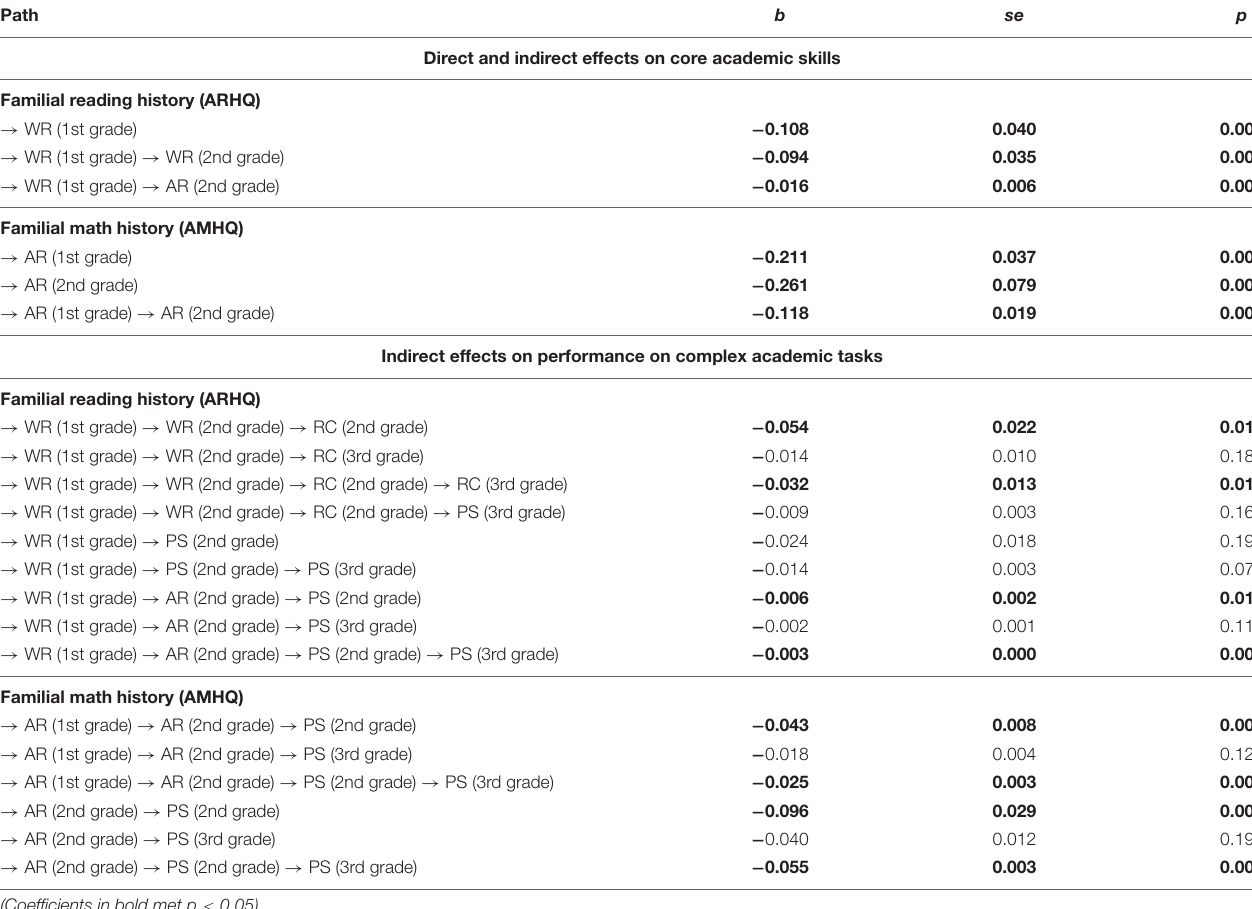
TABLE 6 | Direct and indirect effects of familial history of reading and math difficulties on children’s core academic skills [word reading (WR) and arithmetic calculation (AR)] after first and second grades, and performance on complex academic tasks [reading comprehension (RC) and problem solving (PS)] after second and third grades. Path b se